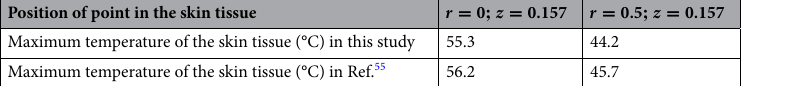
Position of point in the skin tissue r = 0 ; z = 0.157 r = 0.5 ; z = 0.157 Maximum temperature of the skin tissue (°C) in this study 55.3 44.2 Maximum temperature of the skin tissue (°C) in Ref. 55 56.2 Table 3. Comparison of the maximum temperature of the skin tissue obtained in this study with the obtained values in Ref 55 .